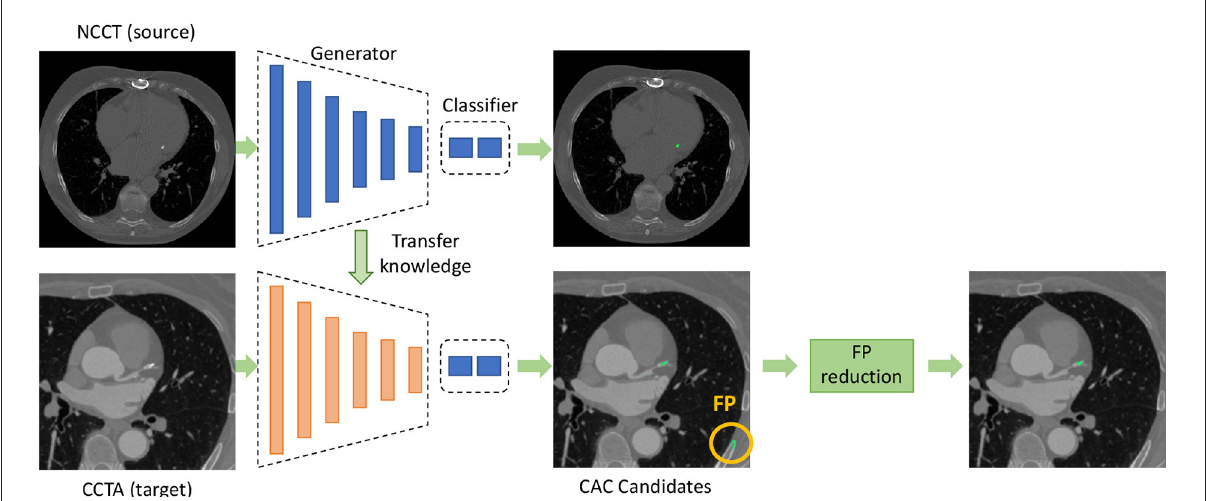
FIGURE1 Overview of the proposed method for coronary artery calcium (CAC) detection in CCTA. The CNN for CAC detection is divided into a feature generator and a classifier. The feature generator is trained on source domain and is adapted to the target domain using unsupervised domain adaptation. The classifier in the target domain is reused from the source domain. After detection of CAC candidates using the CNN, false positive (FP) reduction is applied to remove FP detections.